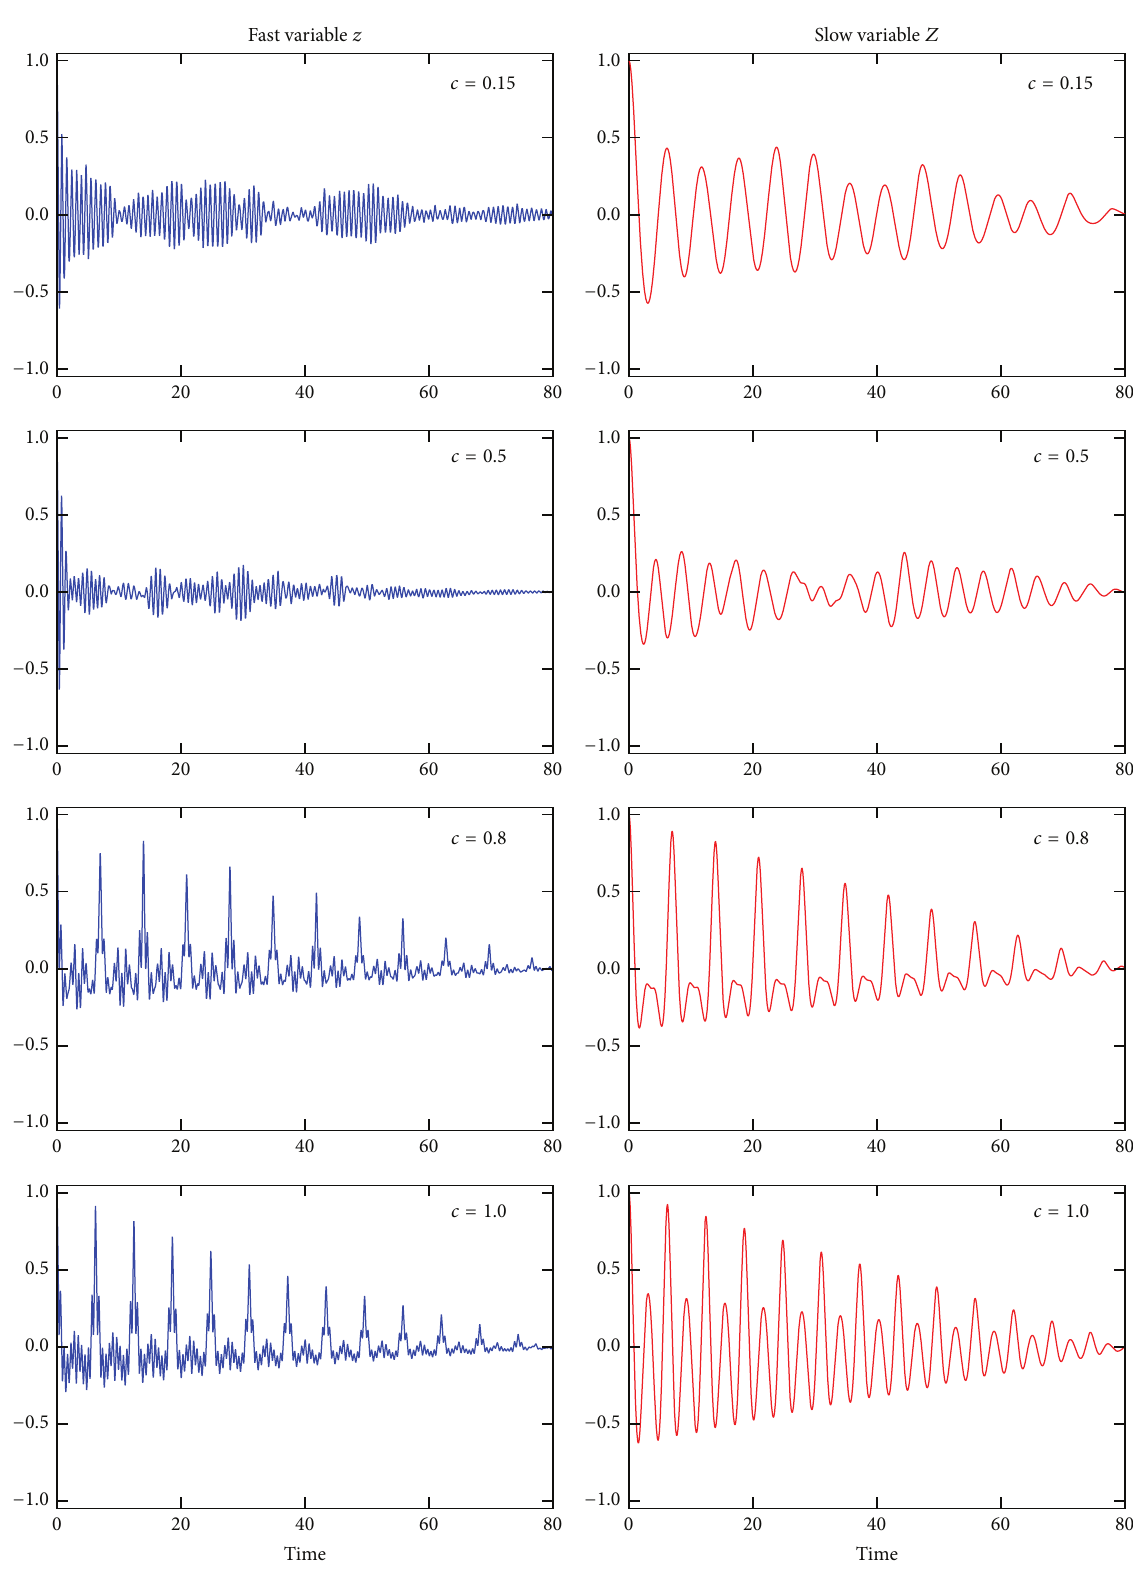
Figure 7: Autocorrelation functions for dynamic variables 𝑥 and 𝑍 for different parameter 𝑐